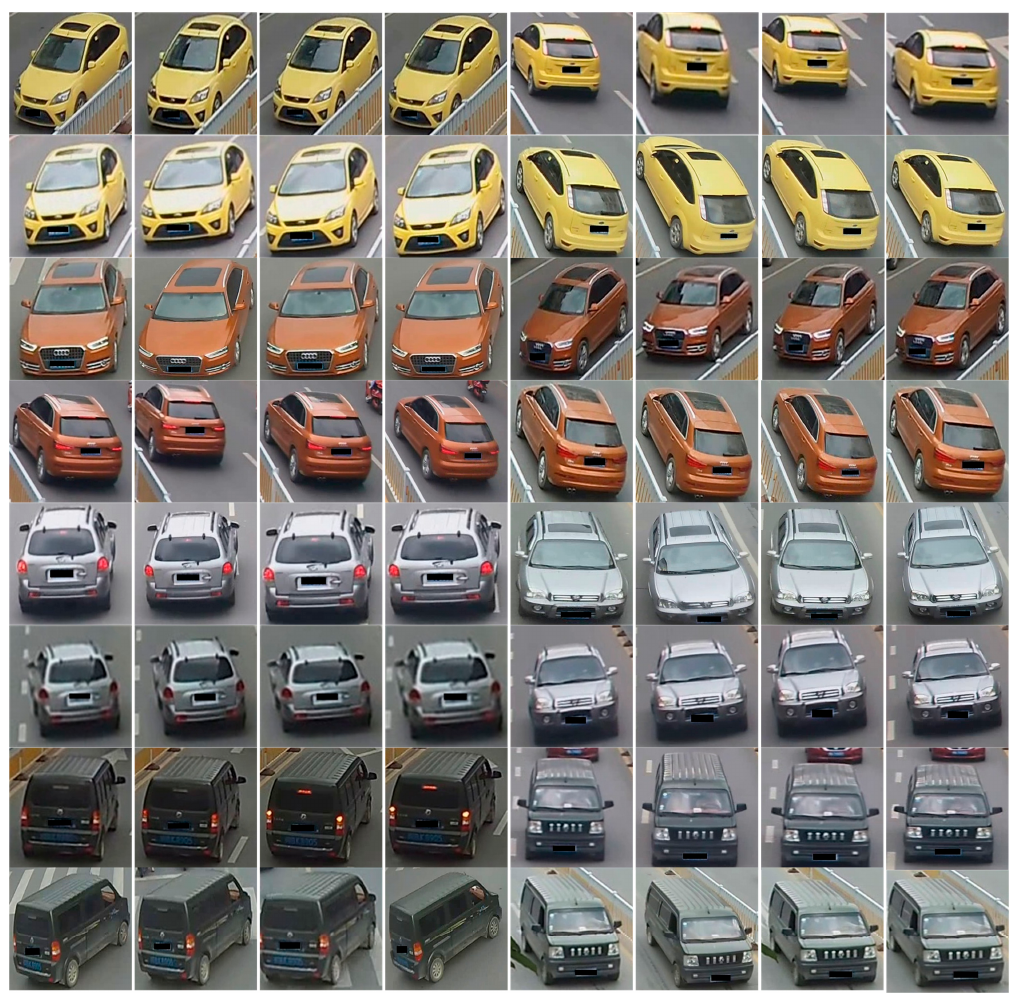
Figure 1. An example of samples using strategy considering viewpoints. P, K, and V are all set to 4. We can see that the images shot by the same camera are similar and images from different viewpoints show the intra-class variance.